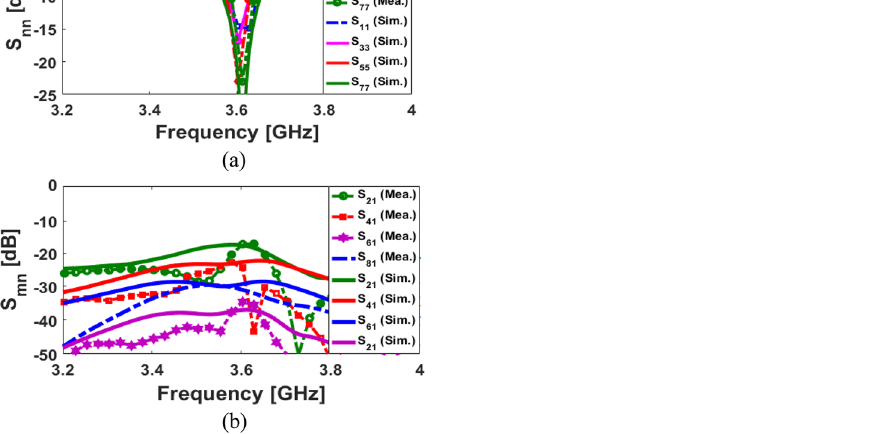
Figure 12. Comparison of the measurements and simulations for ( a ) S nn and ( b ) S mn characteristics.